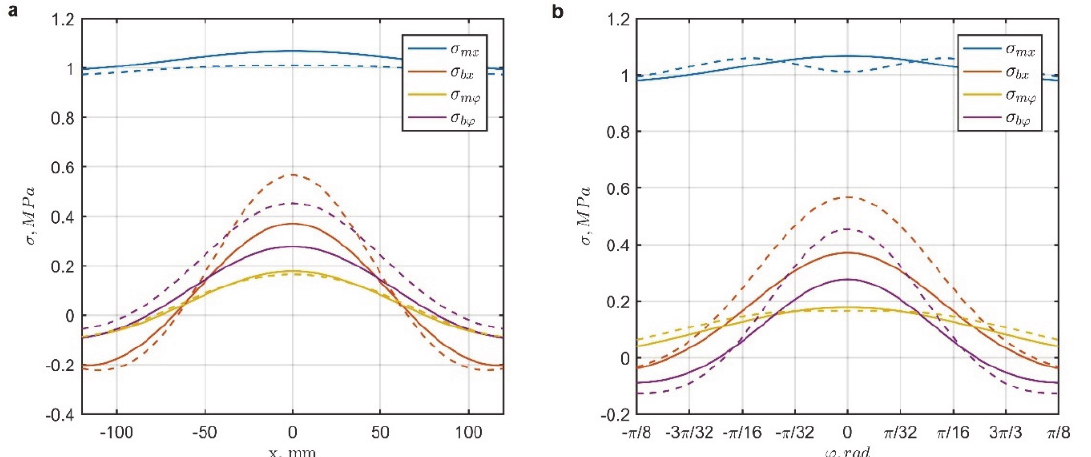
R  = x =60mm, analytical 0 0